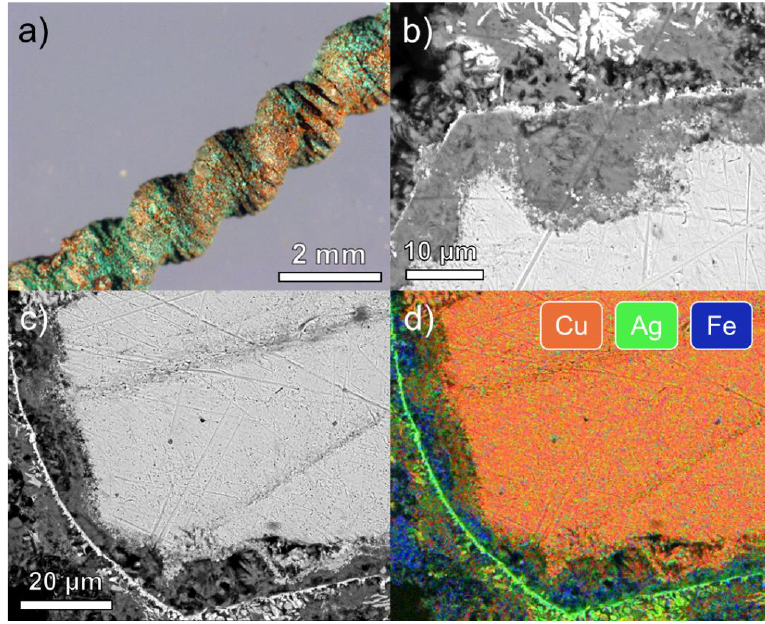
Figure 7. Optical microscopy image of a copper wire ( a ), SEM images (BSE detector) ( b , c ) and coloured maps of the main elements (Cu, Ag and Fe) ( d ) of a cross-section of the copper wire.